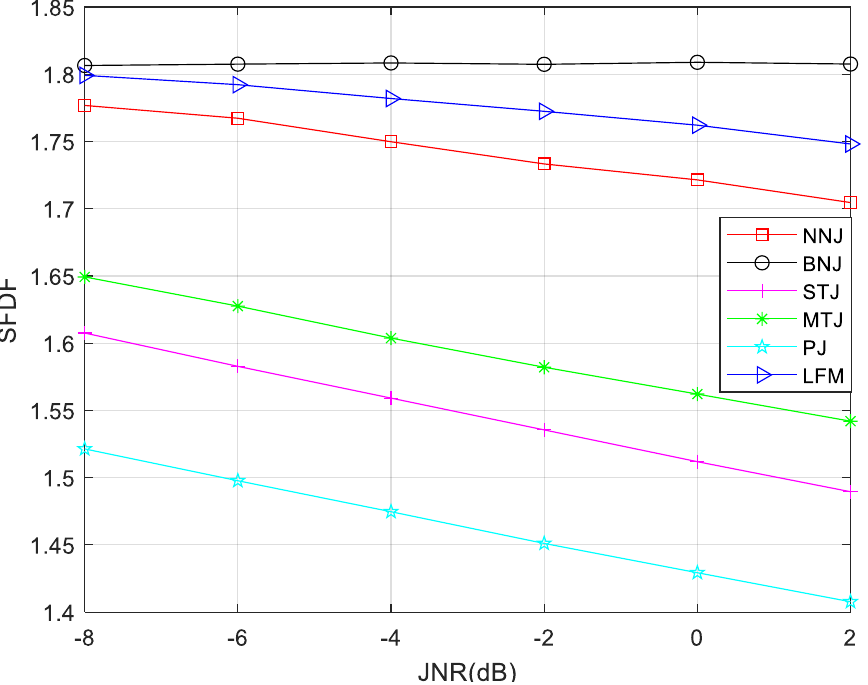
Figure 2. Sevcik fractal dimension from the frequency domain (SFDF) of six kinds of interference changes with the increase in jamming-to-noise ratio (JNR).